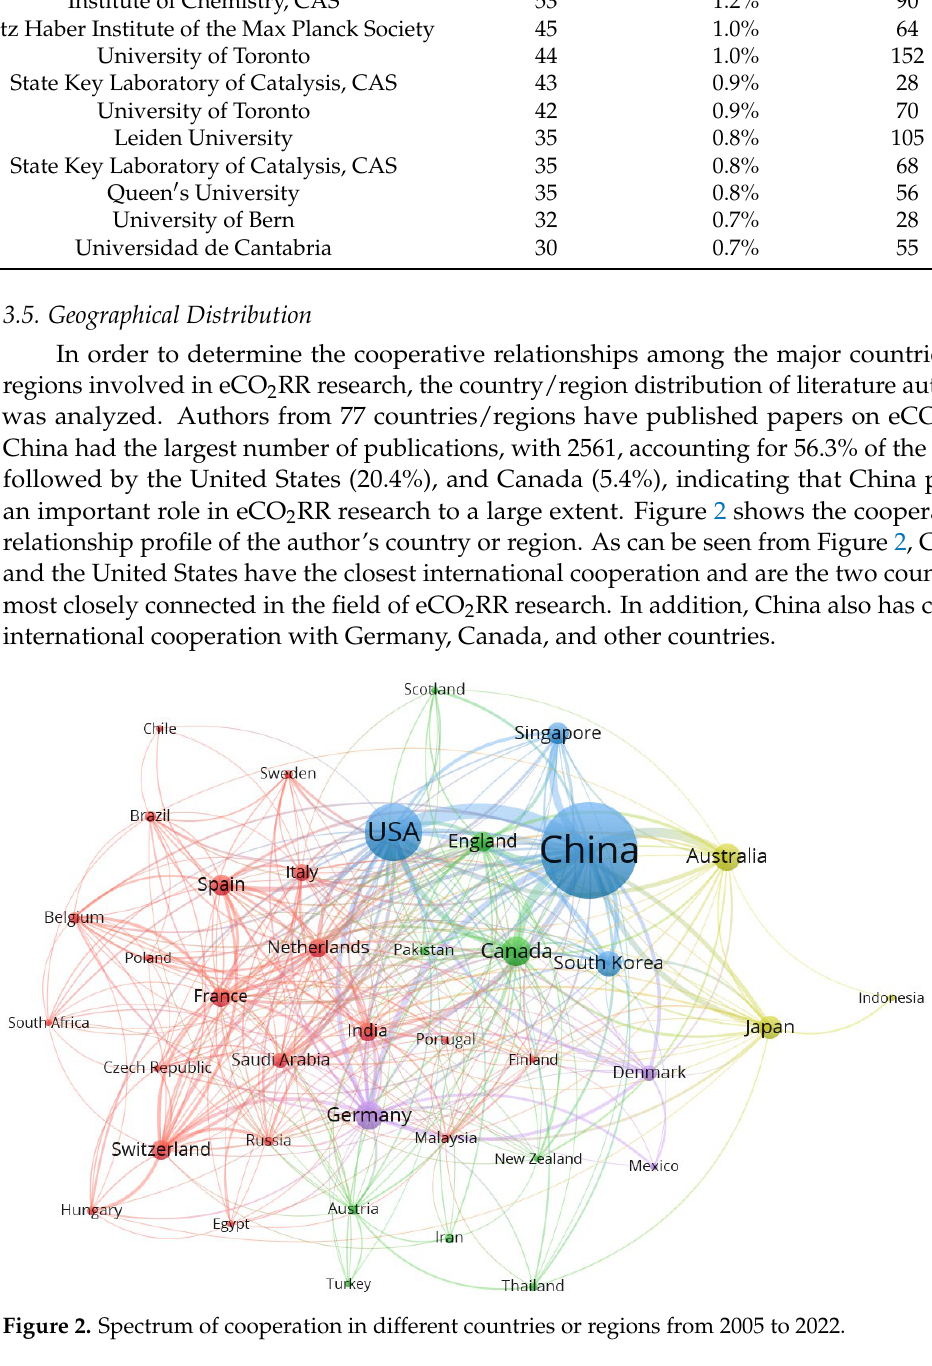
Table 3. Top ten most published authors during 2005–2022.